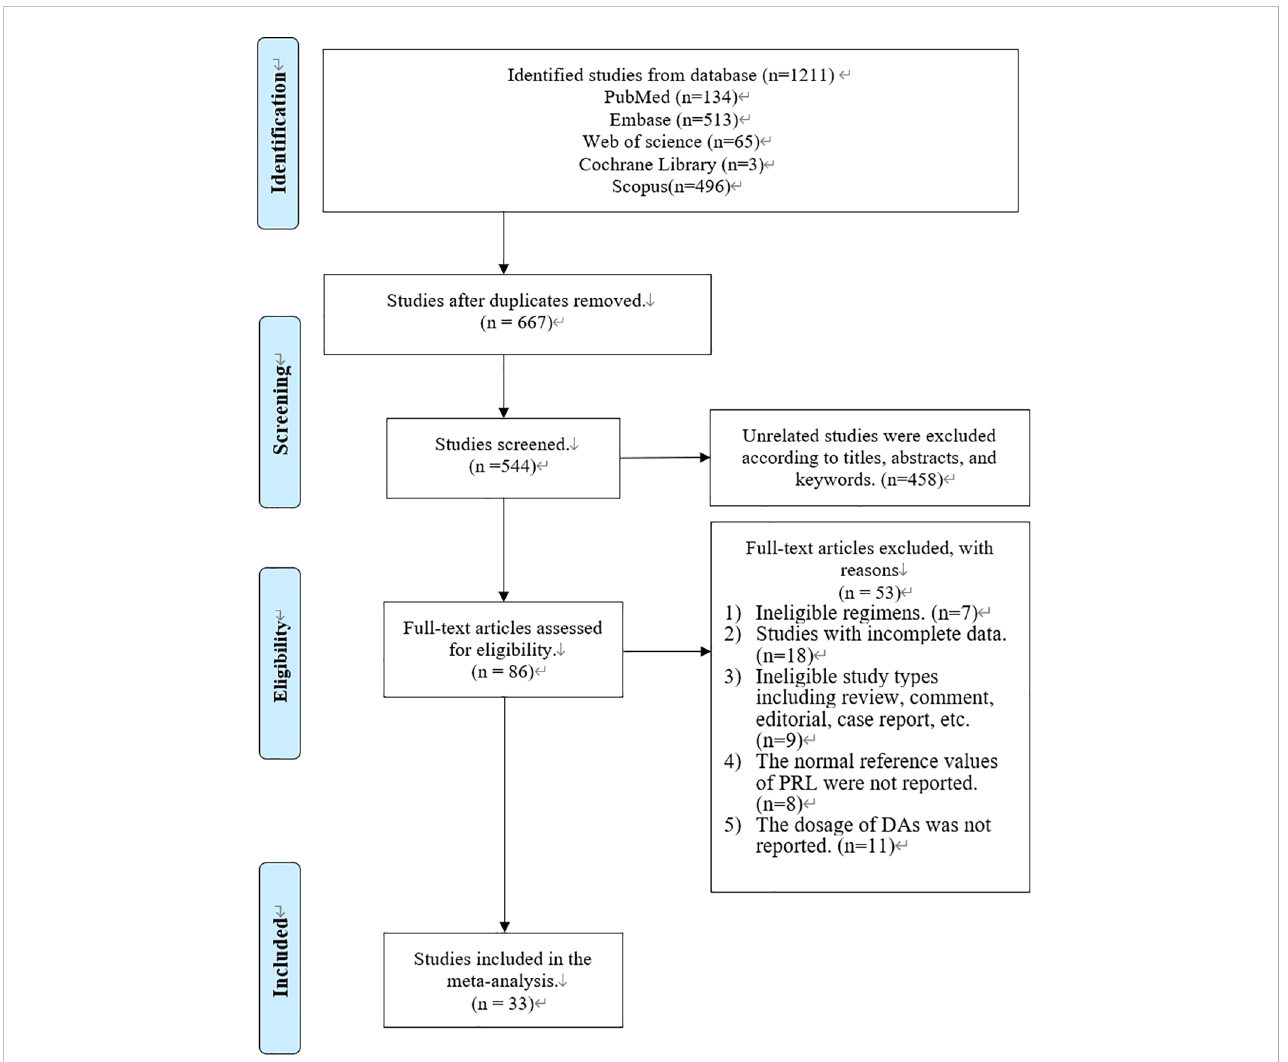
FIGURE 1 Flow diagram of the studies included in this systematic review and